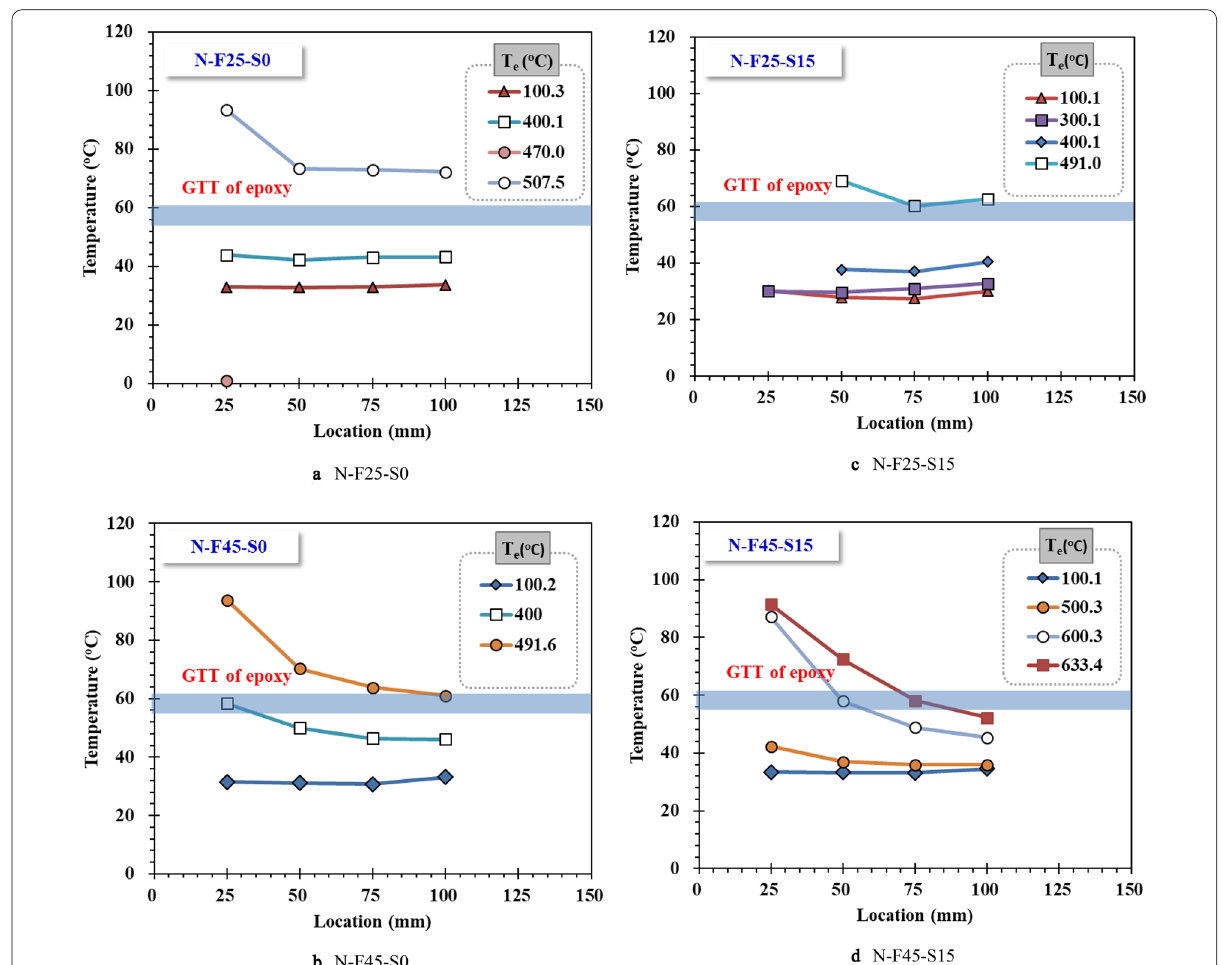
Fig. 16 Temperature profiles of epoxy along its length in NSMR specimens.